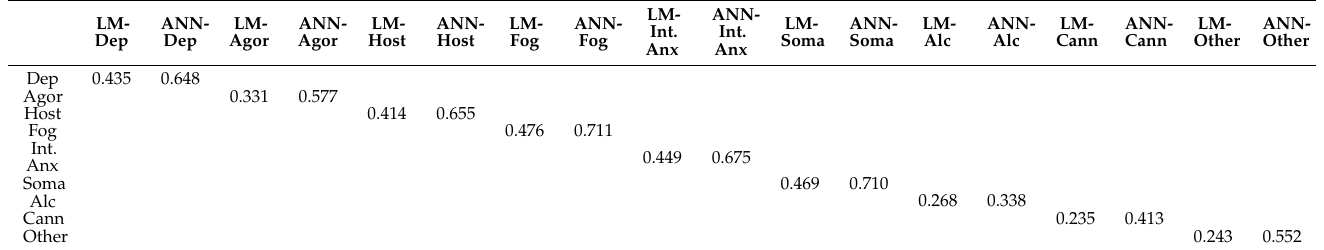
Table 3. Correlations Between Predicted and Actual Lower-Level Psychopathology Scores.